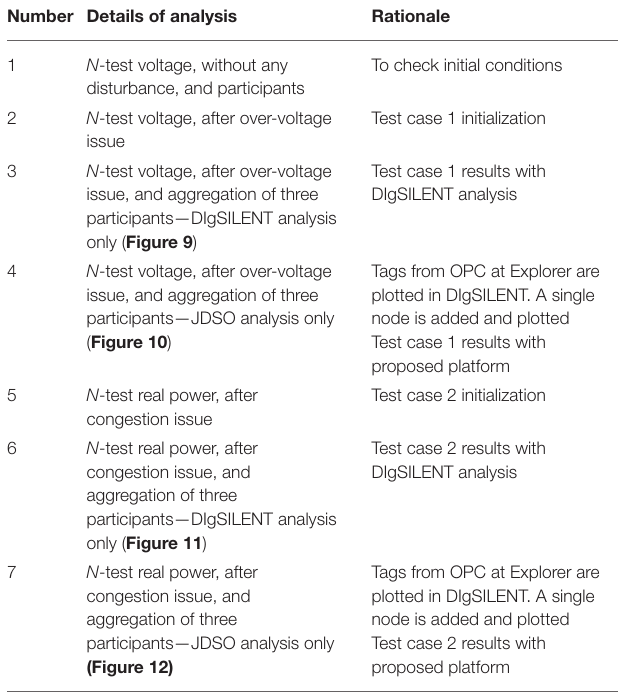
TABLE 4 | Validation table for analysis. Number Details of